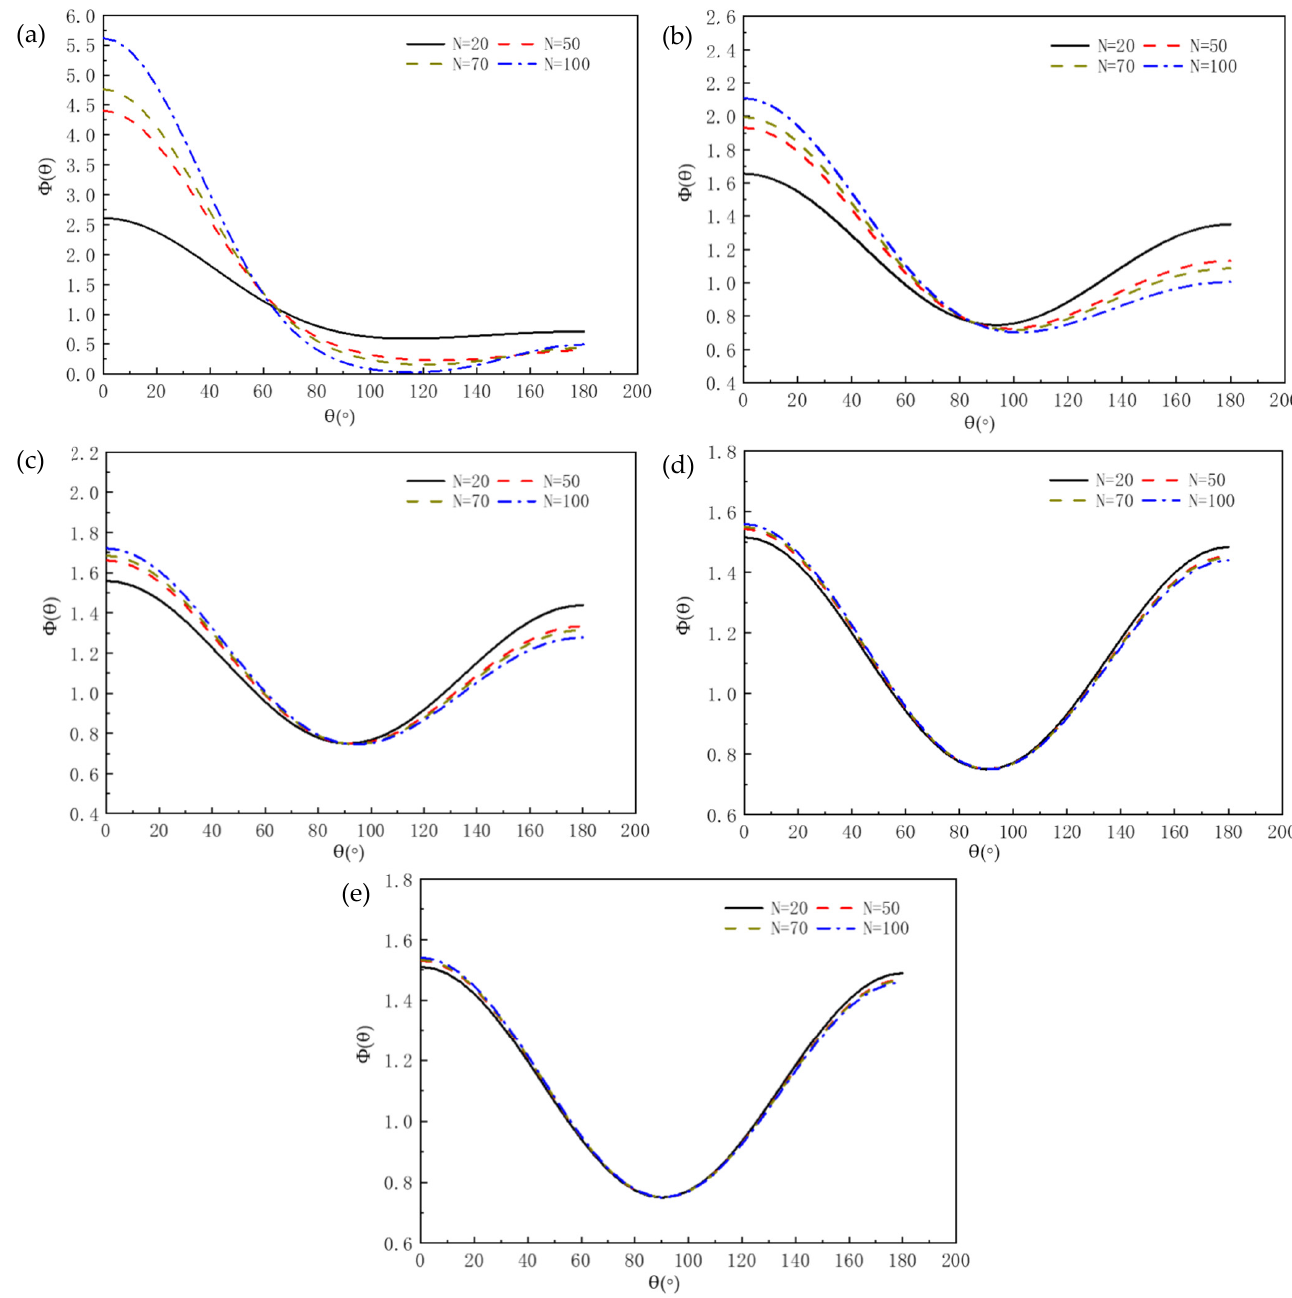
Figure 7. Scattering phase functions of SiC cluster particle changes at different wavelengths: ( a ) λ = 1.064; ( b ) λ = 2.7; ( c ) λ = 4.3; ( d ) λ = 8.3; ( e ) λ = 10 μ m.